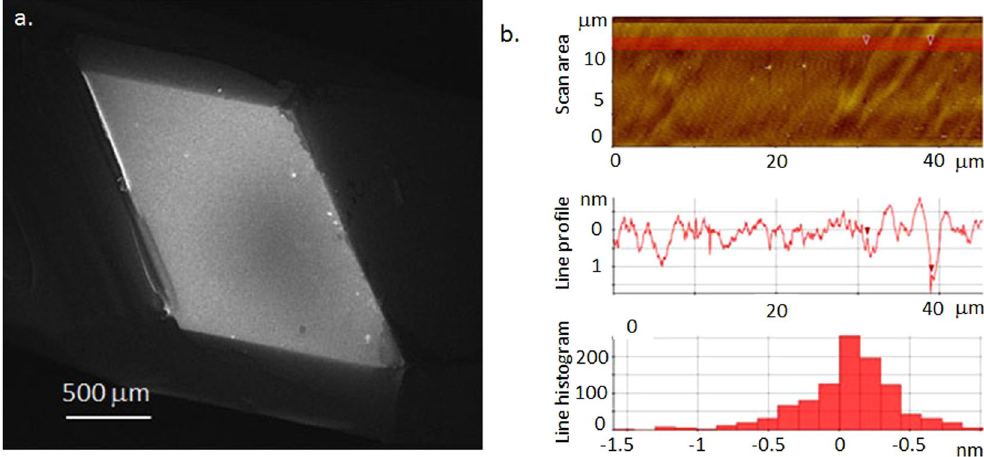
Figure 2. ( a ) SEM image of a freshly cleaved, large surface of CH 3 NH 3 PbBr 3 single crystal. ( b ) AFM topographical scan of a representative area of the surface in Fig. 2a. The line scan shows at some places shallow pits.